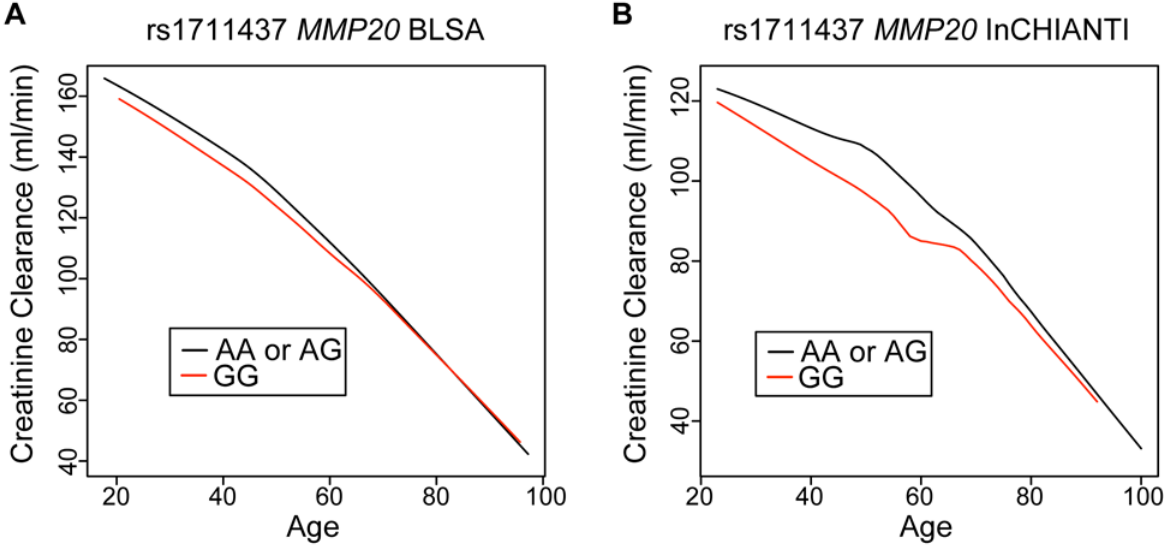
Figure 4. A SNP in MMP20 associates with a kidney aging phenotype. Loess smoothing lines through a scatter plot of creatinine clearance versus age stratified by genotype at rs1711437 in the BLSA (A) and InCHIANTI (B) populations. (corrected